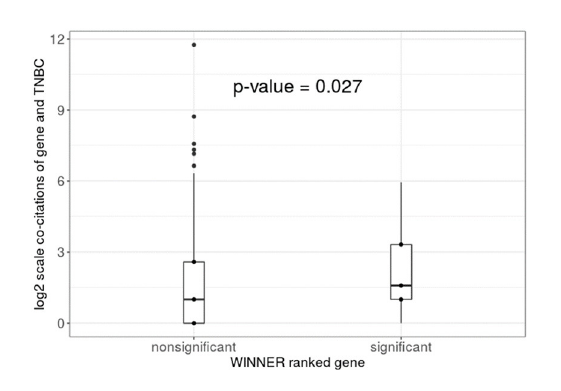
FIGURE10 The literature validation of triple negative breast cancer genes using co-citations from PubMed. The co-citations of gene and TNBC are grouped by the WINNER reported p -values. The non-significant gene p -values are larger than 0.05 in WINNER, and the significant gene p -values are 0.05 in WINNER. The ≤ Kruskal Wallis test p -value is 0.027.